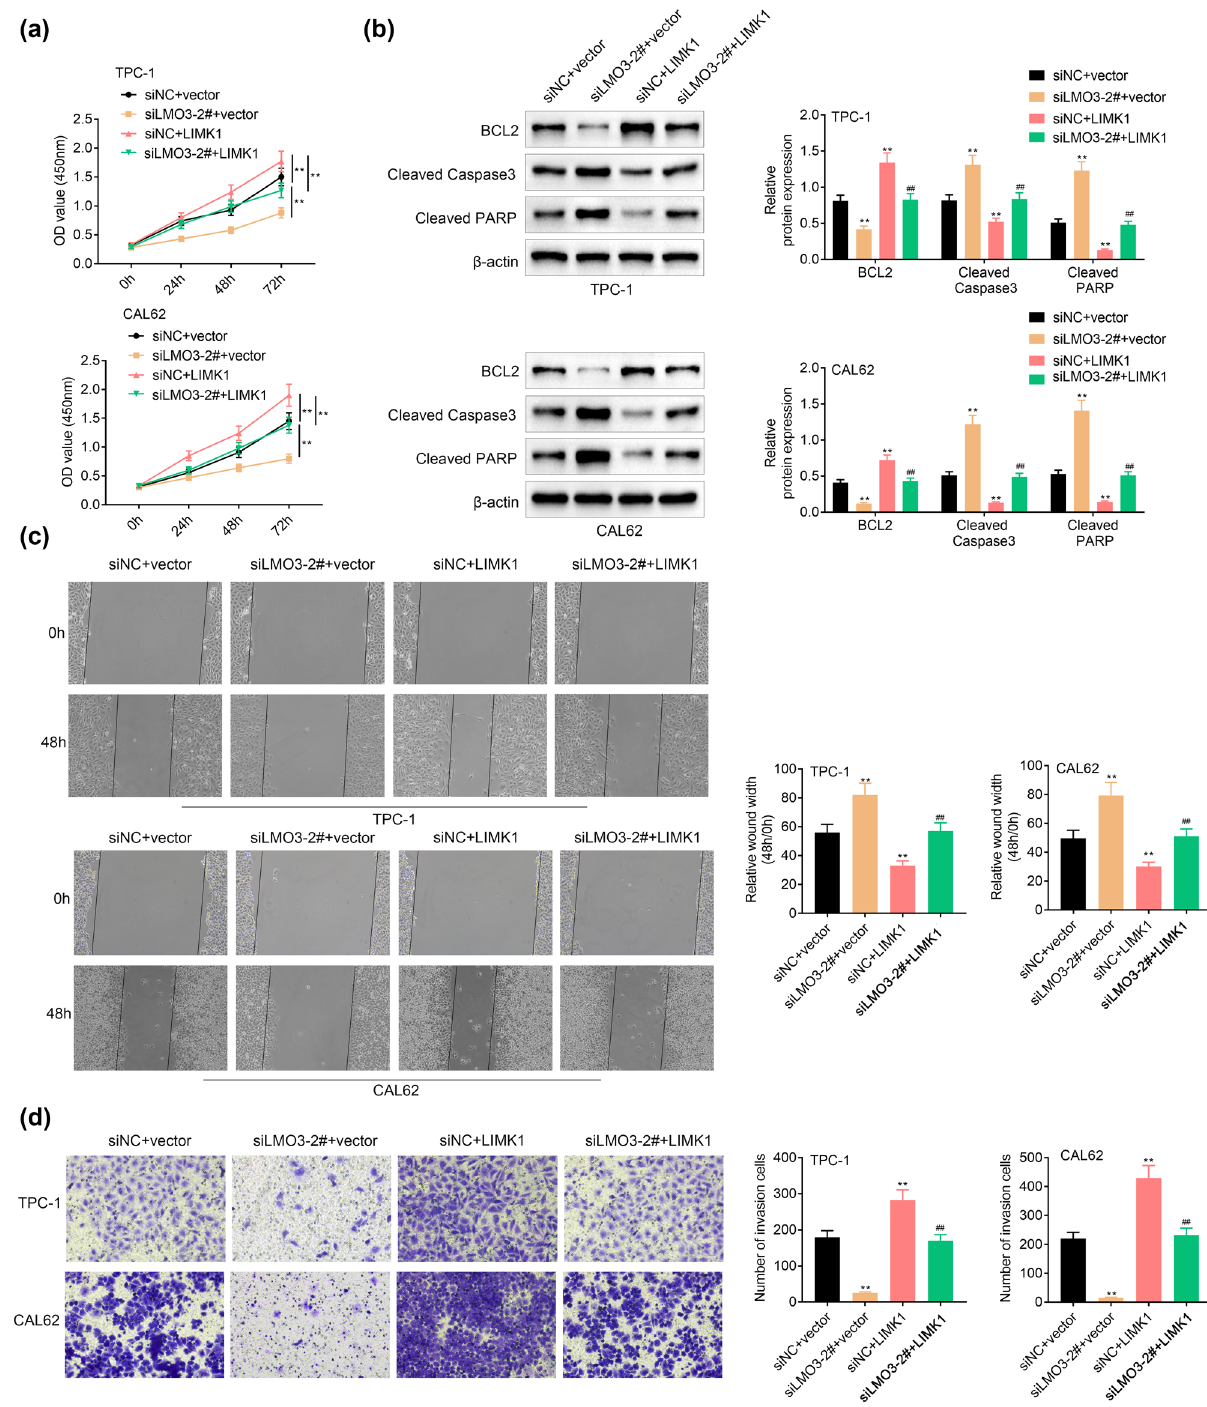
Figure 5: Overexpression of LIMK1 counteracted the suppressive e ff ects of LMO3 silence on PTC cell growth and metastasis. ( a ) Overexpression of LIMK1 increased cell viability of TPC - 1 and CAL62 and weakened silence of LMO3 - induced decrease of PTC cell viability. ( b ) Overexpression of LIMK1 increased protein expression of Bcl - 2, decreased cleaved caspase - 3 and cleaved PARP in TPC - 1 and CAL62, and weakened silence of LMO3 - induced decrease of Bcl - 2 and increase of cleaved caspase - 3 and cleaved PARP. ( c ) Overexpression of LIMK1 promoted cell migration of TPC - 1 and CAL62 and weakened silence of LMO3 - induced decrease of PTC cell migration. ( d ) Overexpression of LIMK1 promoted cell invasion of TPC - 1 and CAL62 and weakened silence of LMO3 - induced decrease of PTC cell invasion. ** vs siNC or siNC + vector, p < 0.01. ## vs siNC + LIMK1, p <